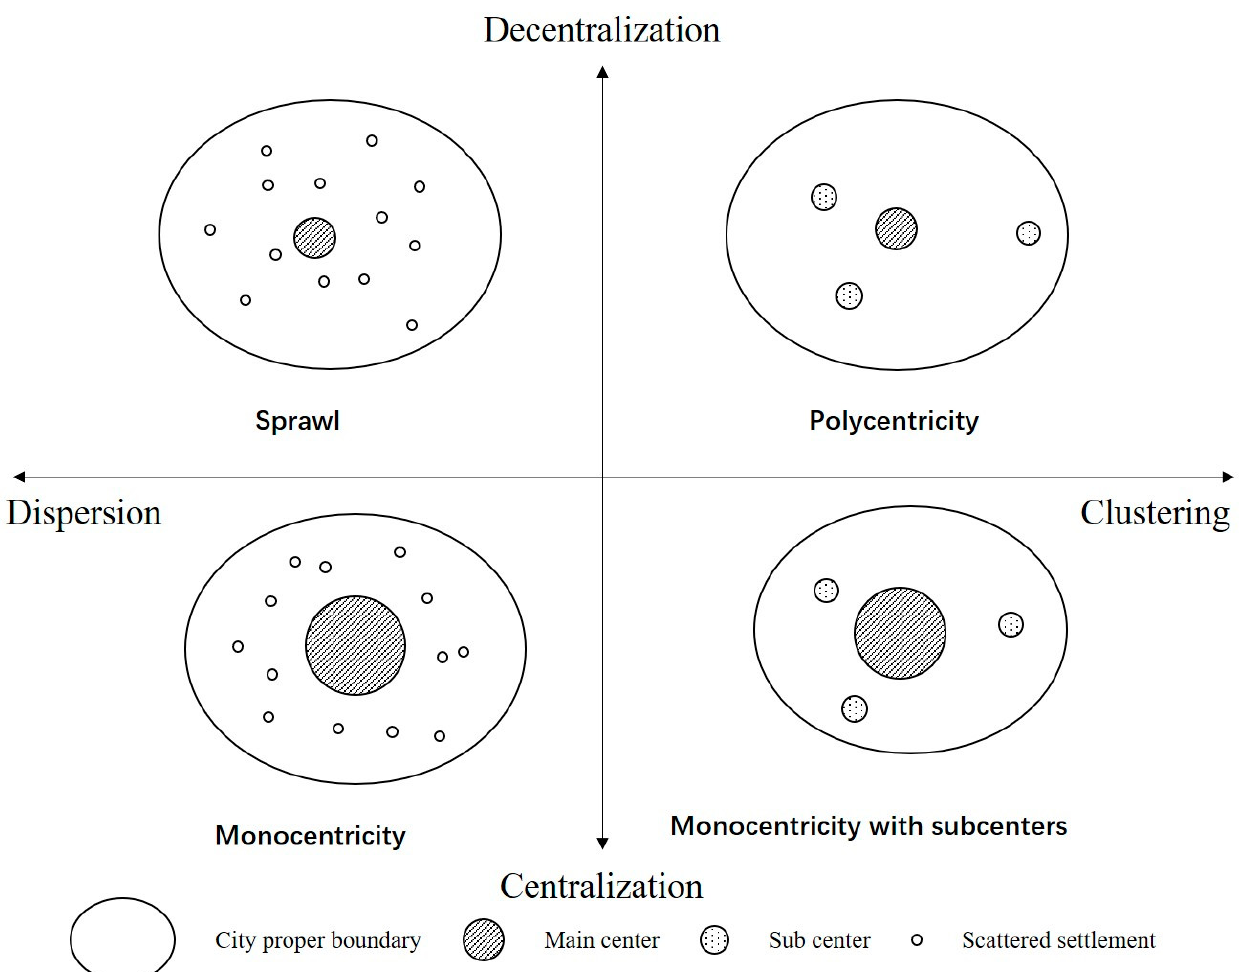
Figure 2. S patial structure dimensions. Figure 2. Spatial structure